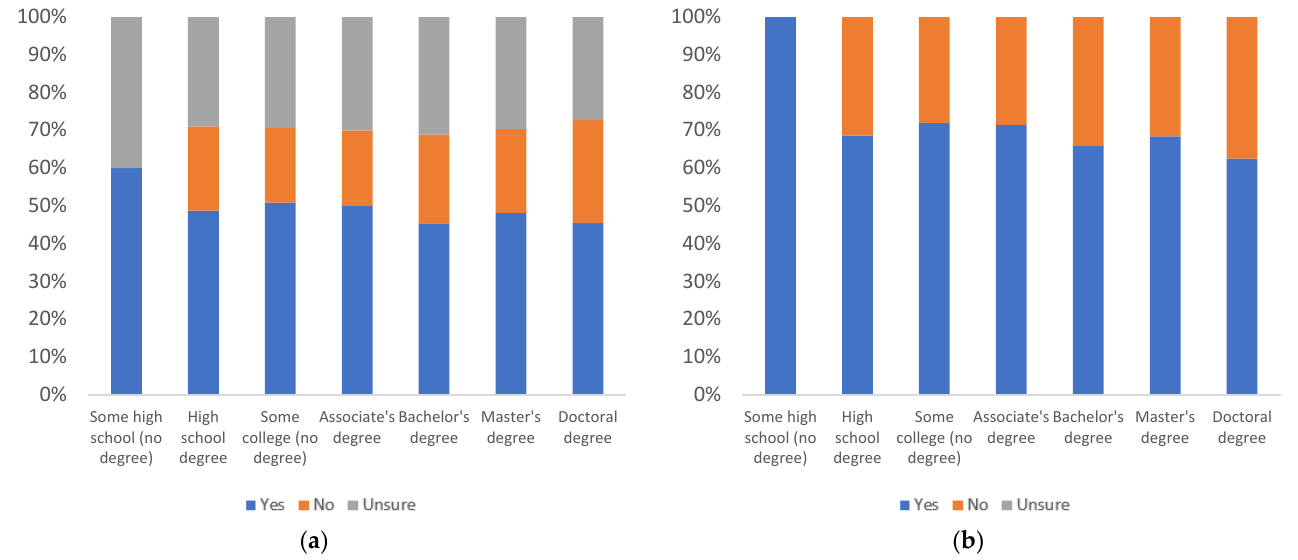
Figure 31. Label others’ use, by education level: ( a ) with uncertain respondents (left) and ( b ) without uncertain respondents (right).